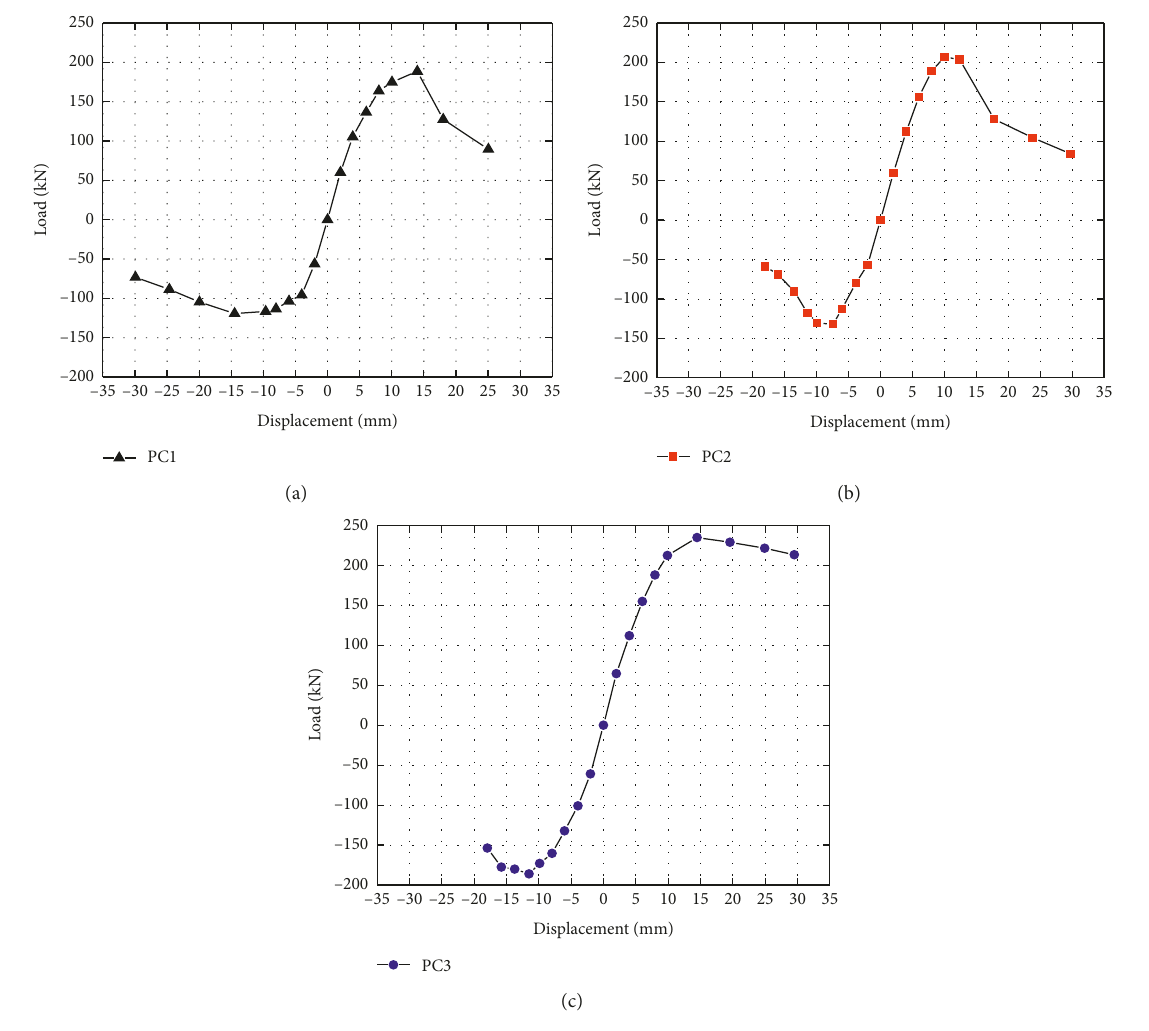
Figure 10: Skeleton curves of specimens. (a) PC1. (b) PC2. (c) PC3. Table 2: Summary of